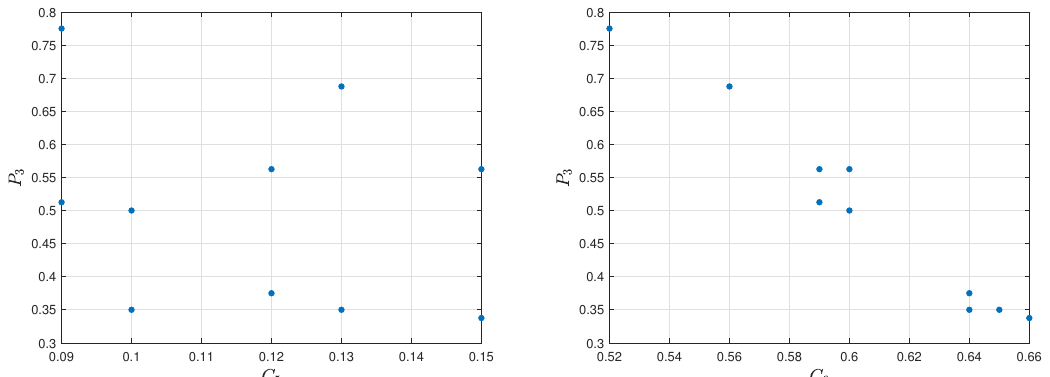
Figure 15. The relation diagram of Average assists per round ( C 5 ) for assessment P 3 ( left side ) and Average deaths per round ( C 6 ) for assessment P 3 ( right side ).